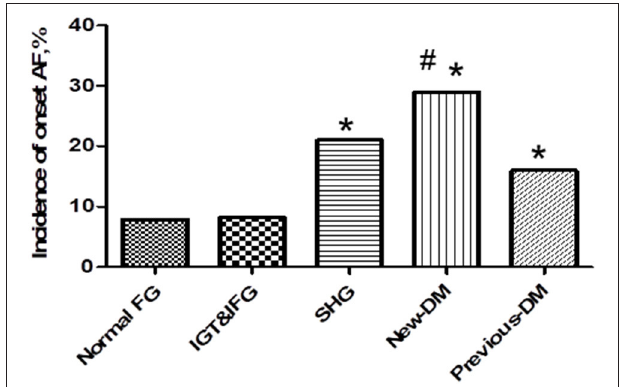
FIGURE 2 | Incidence of new-onset atrial fibrillation among stress hyperglycemia (SHG group), newly diagnosed diabetes (New-DM group), and previous diabetes (previous-DM group). Previous-DM patients, newly diagnosed DM patients and SHG patients had a higher rate of new-onset fibrillation compared with patients with normal FG group (16 vs. 29 vs. 21 vs. 7.8%,* P < 0.05), while there is no statistic difference among the three groups (16 vs. 29 vs. 21%, # p =